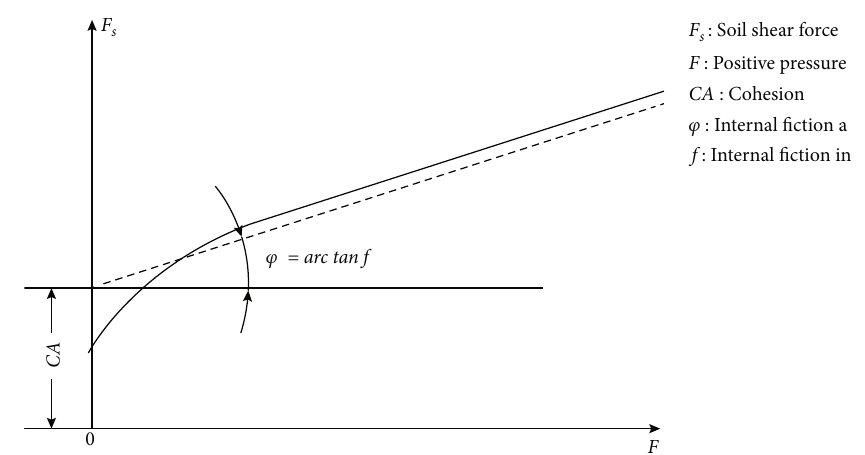
Figure 2: Correspondence between positive stress, soil shear force, and angle of internal friction [40].